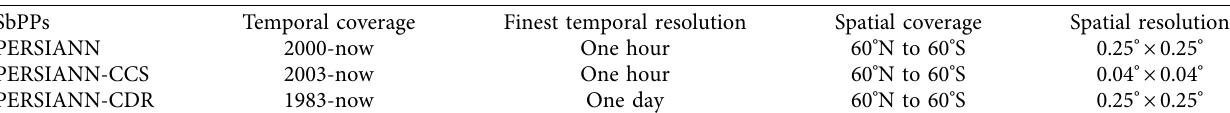
Table 2: Details of